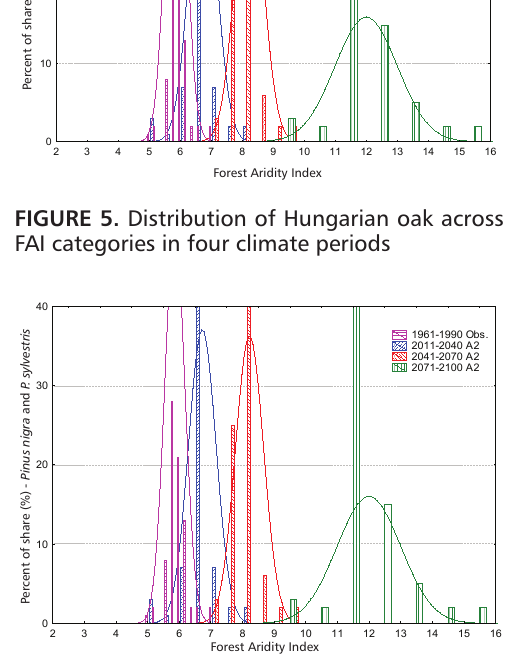
FIGURE 6. Distribution of European beech across FAI categories in four climate periods